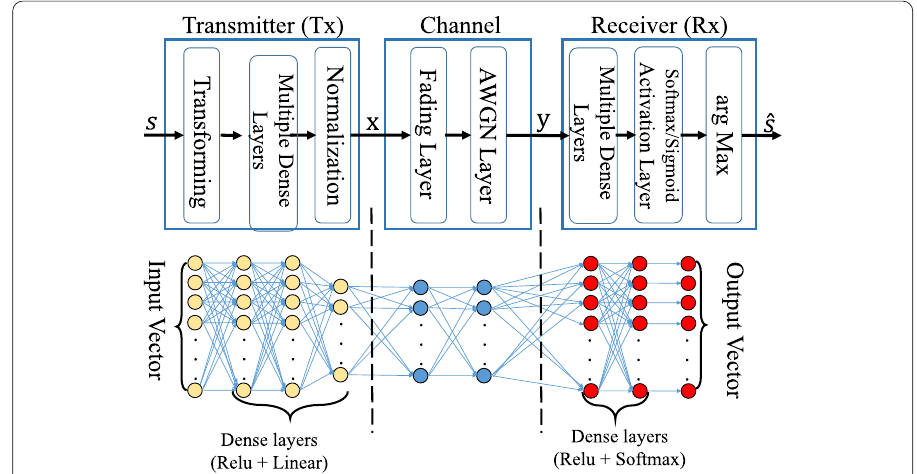
Fig. 1 The layered structure of an end-to-end deep learning-based communications system modeled as an of encoders and decoders), and the system performance (represented by the average power consumption and target BLER).